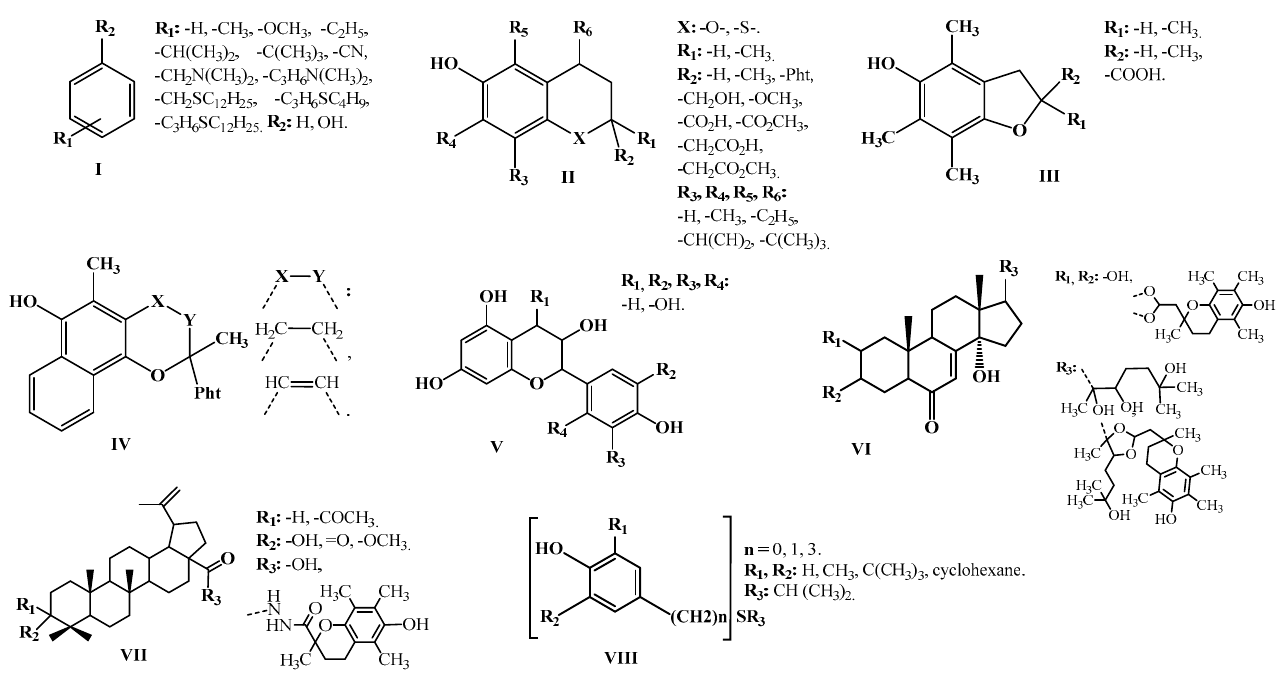
Figure 1. General structural of the formulas of the modeled antioxidant inhibitors Figure (Pht=CH 2 [CH 2 CH 2 CH(CH 3 )CH 2 ] 3 H). I, VIII (a phenol derivative), II–V (chromone derivatives), VI